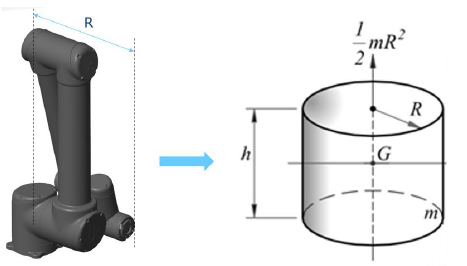
Figure 13. Equivalent inertia for the cobot stowed